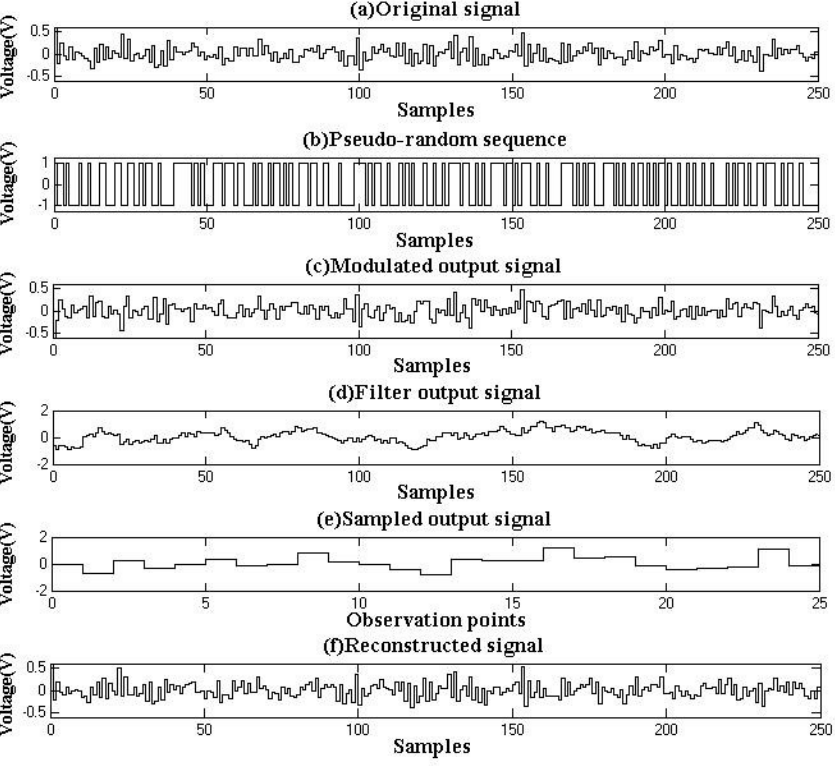
Figure 4. AIC system simulation